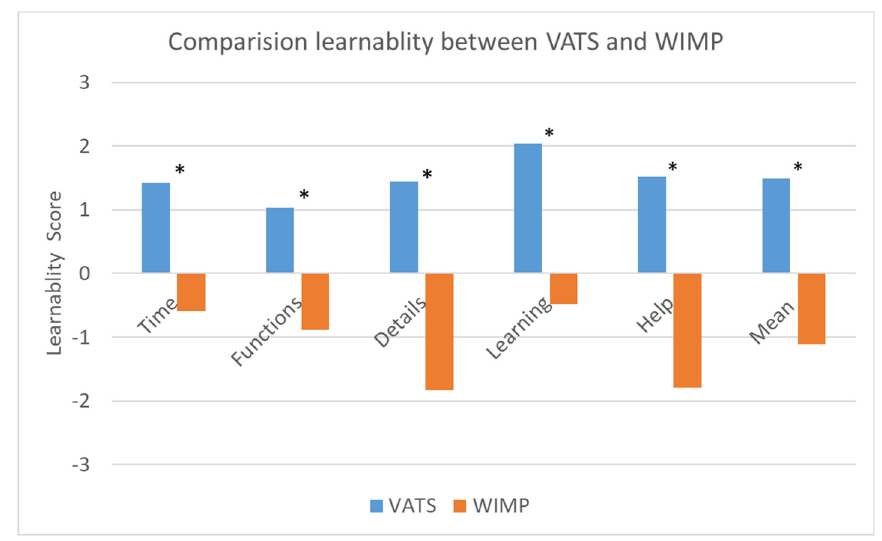
Figure 10 . Results of the learnability questionnaire. The values are (first value VATS, second WIMP): Time: 1.4/ − 0.6; Functions: 1.0/ − 0.9; Details: 1.4/ − 1.8; Learning: 2.0/ − 0.5; Help: 1.5/ − 1.8; Mean: 1.5/ − 1.1